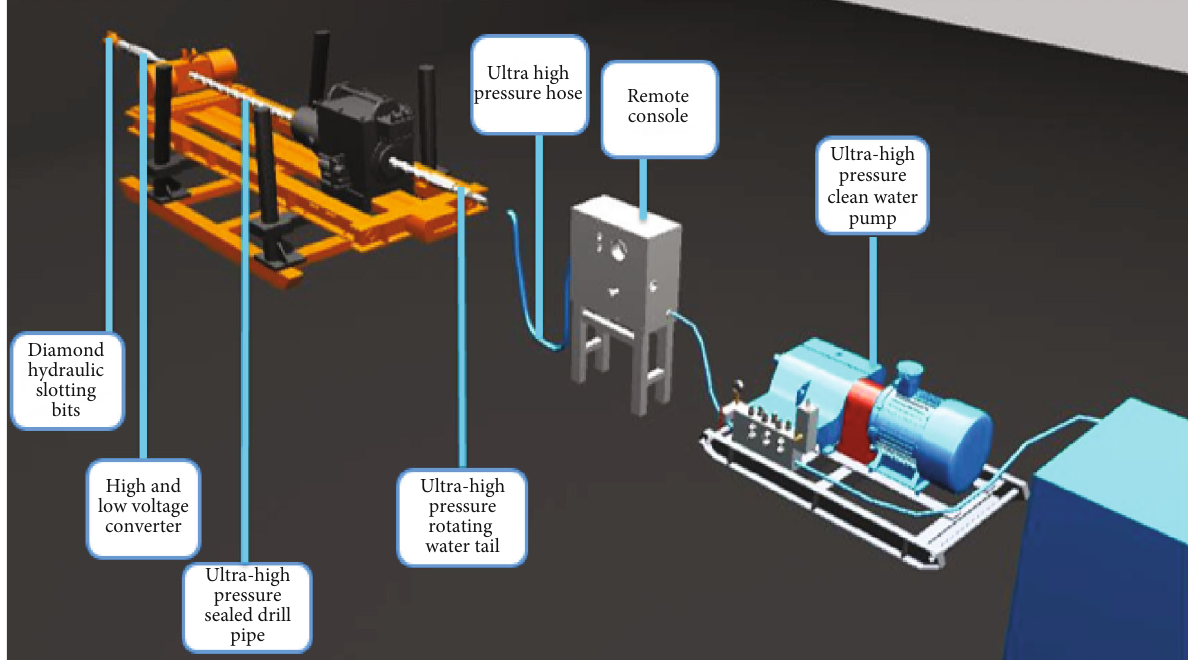
Figure 7: Composition of integrated equipment for ultra-high-pressure hydraulic slitting, drilling, and cutting.